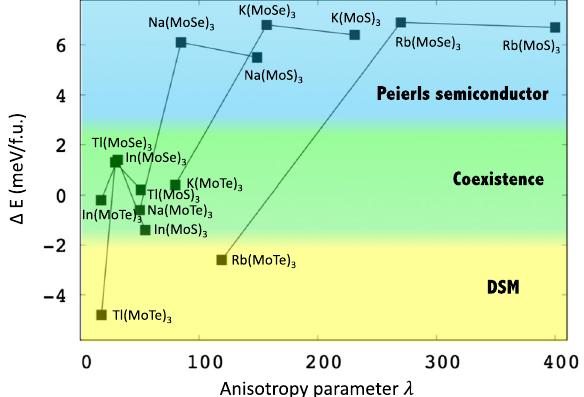
function of anisotropy parameter λ for 15 A ð MoX Þ 3 compounds. The black lines connecting compounds with the same A cation are a guide to the eye.